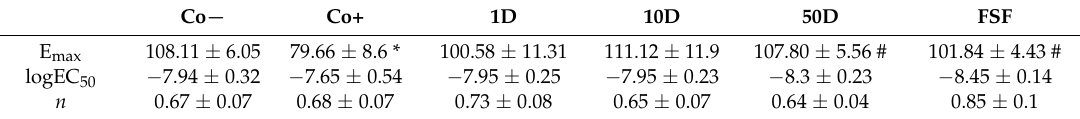
Table A1. Regression parameters (expressed in mean ± SEM) of the Hill equation fitted to the individual modified acetylcholine (Ach) concentration-response (E/c) curves. Level of statistical significance for differences between the positive vs. negative control groups (asterisk), and between the diosgenin and fenugreek treated groups vs. positive control group (hash mark) is indicated (*, #: p < 0.05).